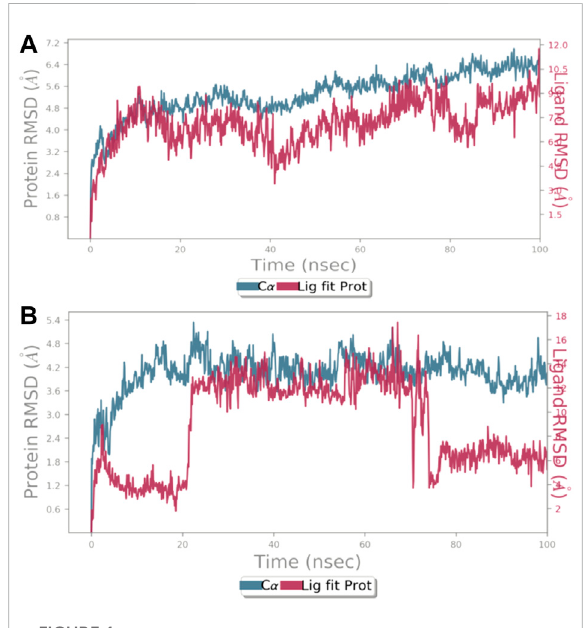
FIGURE 1 (A) represents root mean square deviation (RMSD) for protein 4UX2 shown in blue and RMSD of bergapten shown in red. (B) RMSD for protein 1T3S shown in blue and RMSD of bergapten shown in red using the Desmond software